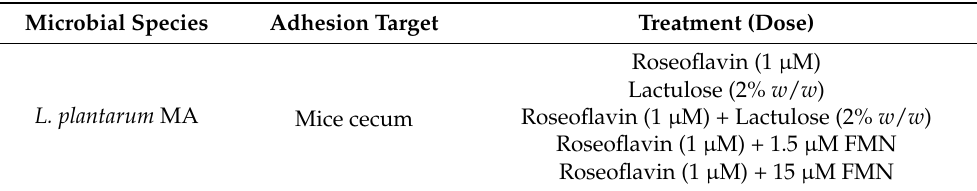
Table 3. Experimental design for microbial adhesion assay ex